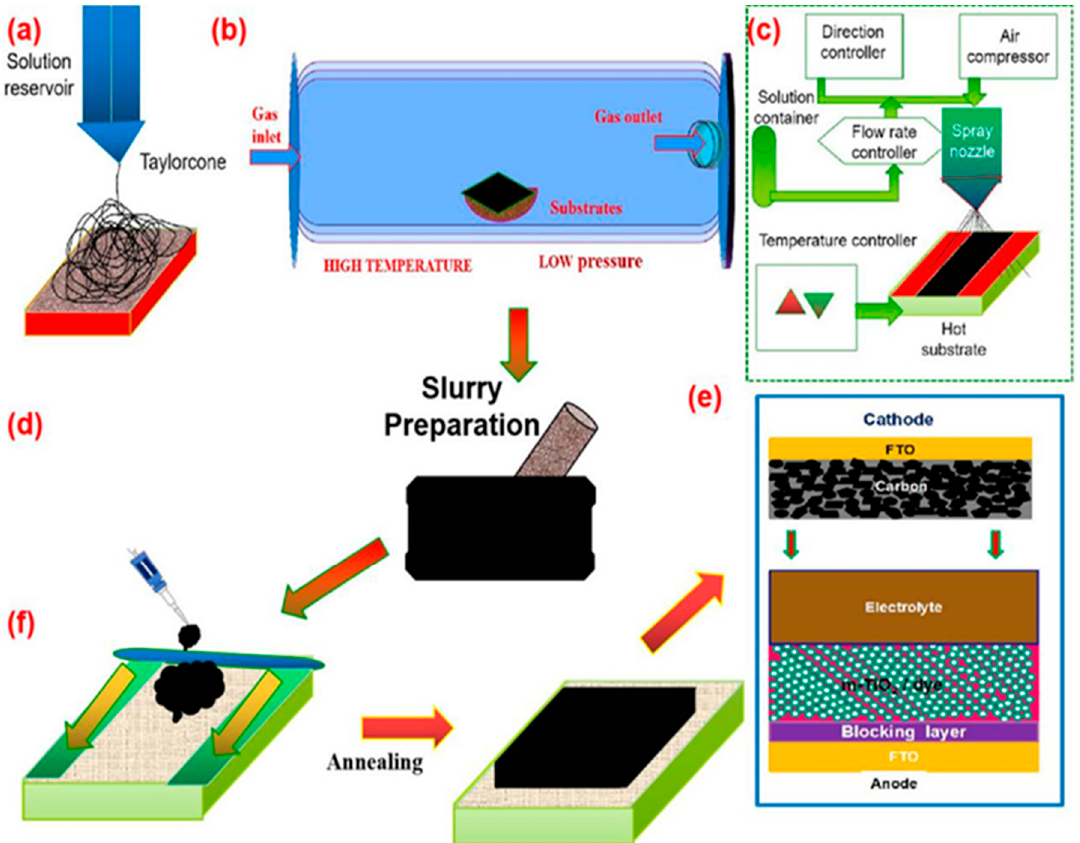
Figure 6. Schematic diagrams of different synthesis and fabrication methods of carbon materials used as CEs in DSSCs: ( a ) electrospinning method, ( b ) CVD method, ( c ) spray pyrolysis method, ( d ) slurry method, ( e ) CE fabrication method, and ( f ) doctor blade method.